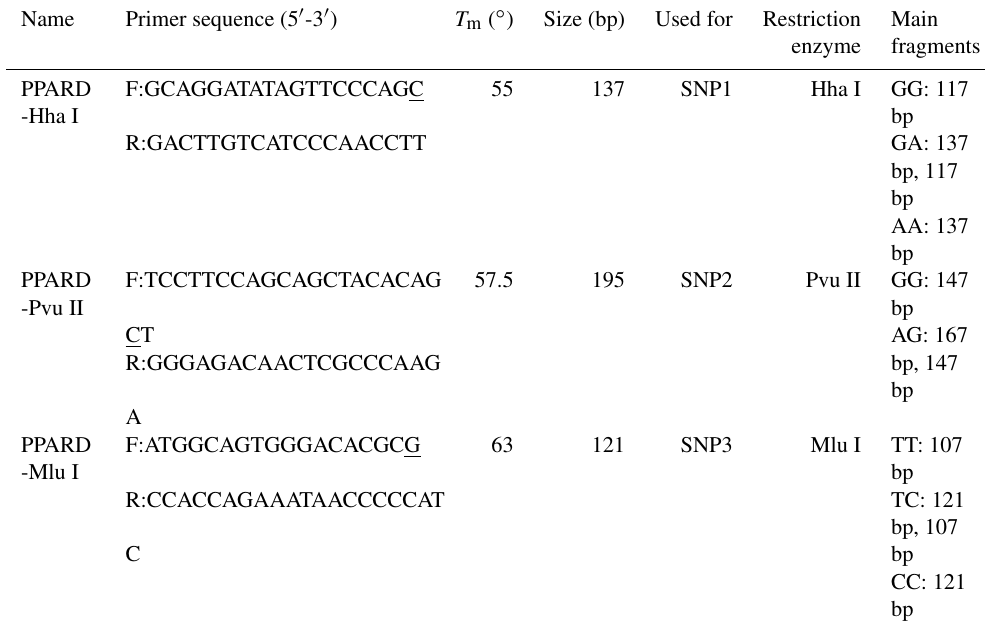
Table 1. Details of SNPs detected in the bovine PPARD gene. Label Position Alleles rs number Functional consequence SNP1 AC_000180.1: 9268142 G>A T>C intron 6